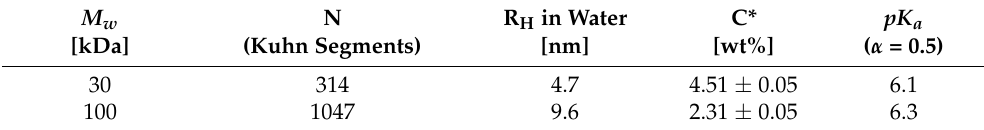
Table 1. Polyacrylic acid properties in salt-free solutions [10].